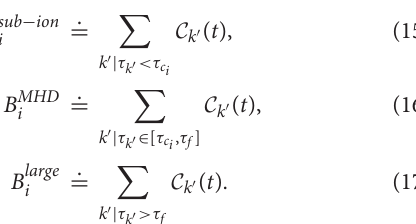
FIGURE 3 | The Hilbert-Huang energy spectrum S ( t , τ ) for each magnetic field component ( B x , B y , and B z , in the left, middle, and right panels) for the first (top) and the second (bottom) Mercury flybys, respectively. The white line corresponds to the ion-cyclotron scale τ c the bow shock and magnetopause crossings, respectively. The instrument noise is < 20 pT/Hz 1 / 2 at 1-Hz intrinsic noise level [ 23]. For optimal visualization, data are shown within the logarithmic range [ − 4,2], allowing the colormap saturation above